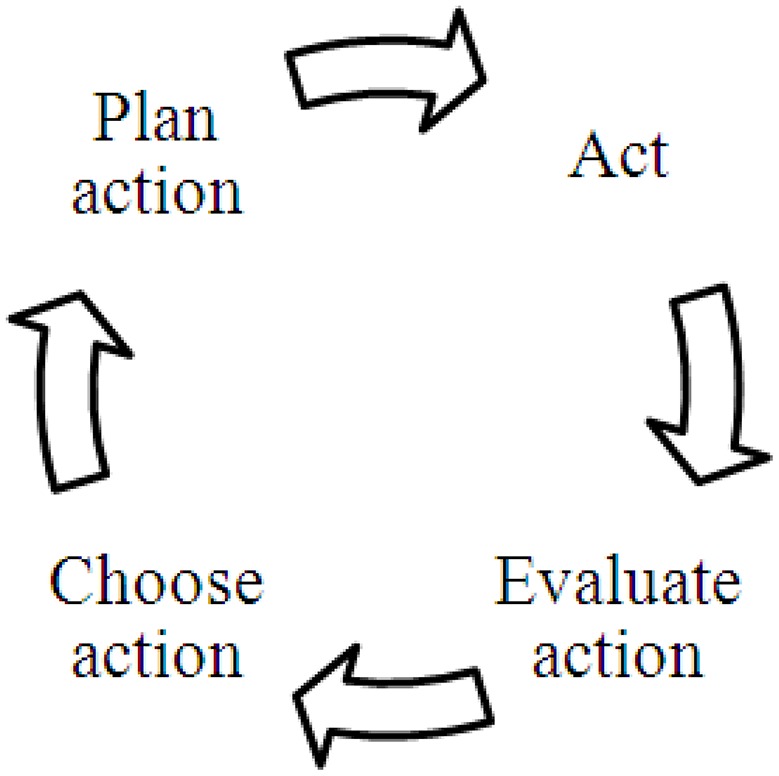
Process model of goal-directed action [example: single-goal perspective]. This figure merges the linear model of action phases (Gollwitzer, 1990; Heckhausen, 1991) and cyclical models of self-regulation (e.g., Zimmerman, 2008) to reflect the ongoing stream of individuals' actions.